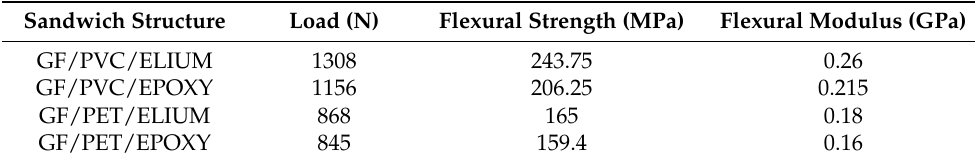
Figure 8. Failure behavior of the sandwich structures with different foam and resin underneath. Table 3. Flexural test results of sandwich GFRP